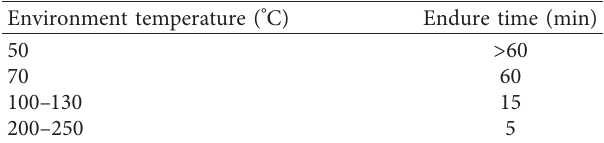
Table 4: Effects of high temperature on the human